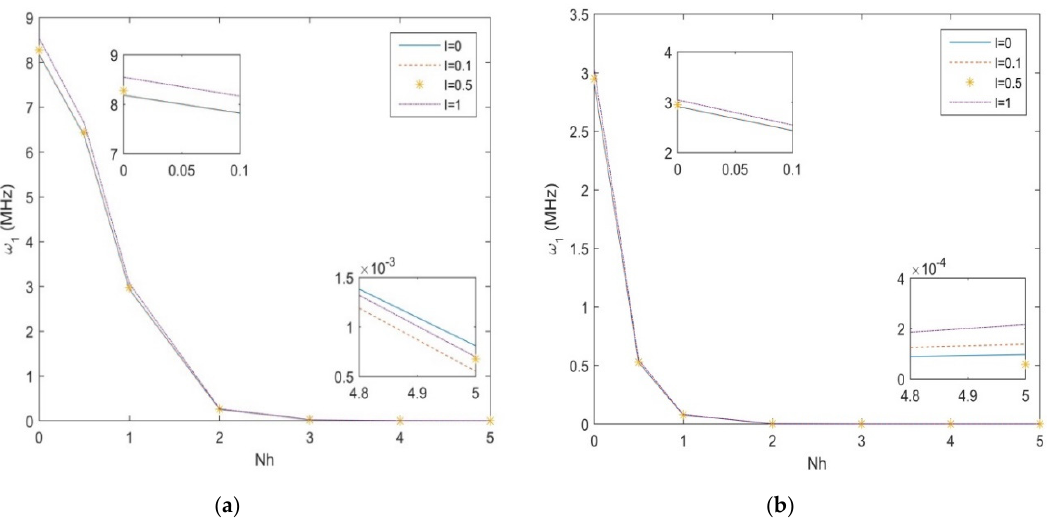
Figure 4. The 1 st natural frequency for a S-S (a) and C-F (b) beam vs. non-uniformity parameter for different length-scales.